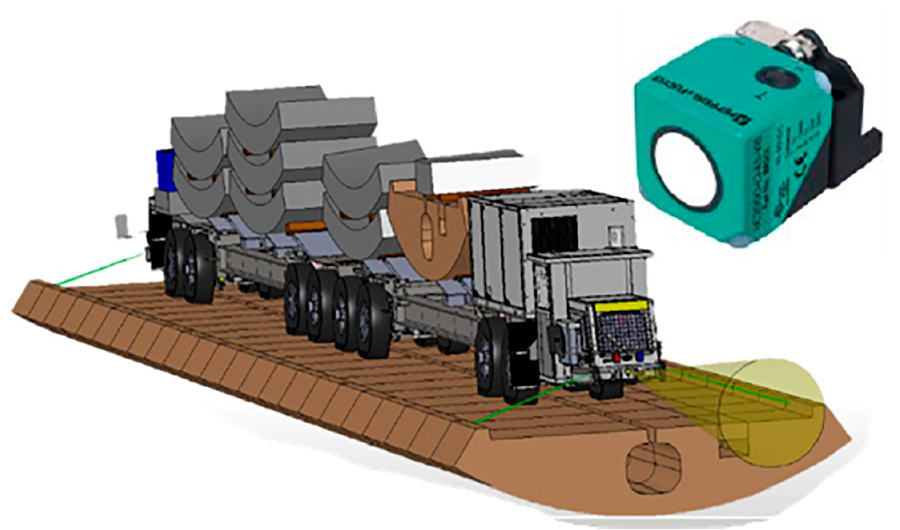
Figure 6. Ultrasonic sensor, which transmits the detection information to the driver’s cab by means of warning lights of different colors.